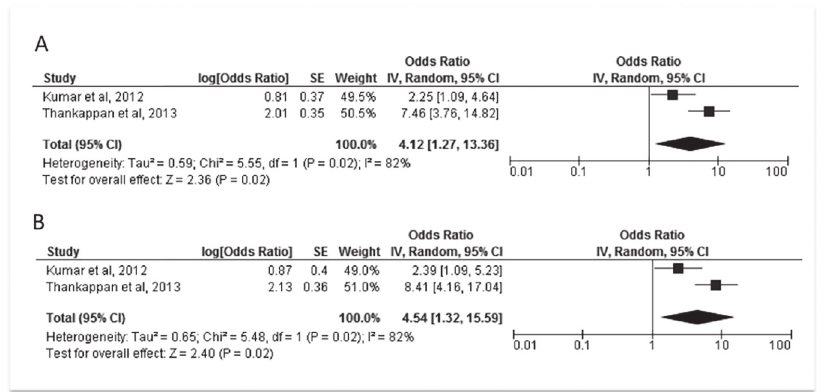
Fig 2. Meta-analyses of data from non-pharmacological cessation interventions. Forest plots, effect estimates and measures of heterogeneity, relating to the meta-analyses performed with unadjusted (A) and adjusted (B) data are